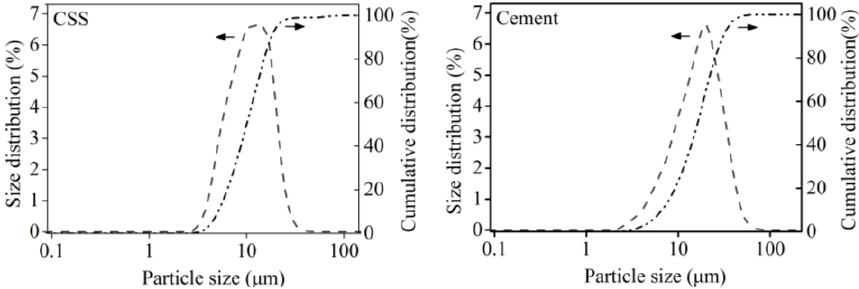
Figure 1. Particle size distribution of CSS and cement.